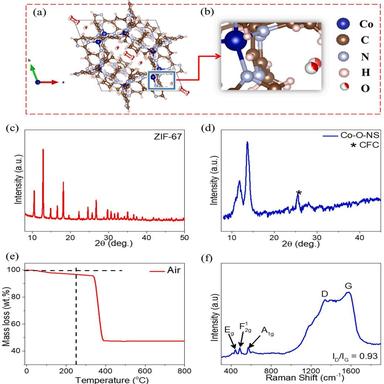
(a) Crystal structure of Bulk ZIF-67, (b) Close view, (c) XRD pattern of precursor ZIF-67, (d) calcined sample, (e) TGA curve of Co-O-NSs@CFC under air atmosphere, and (f) Raman spectrum of Co-O-NSs@CFC.